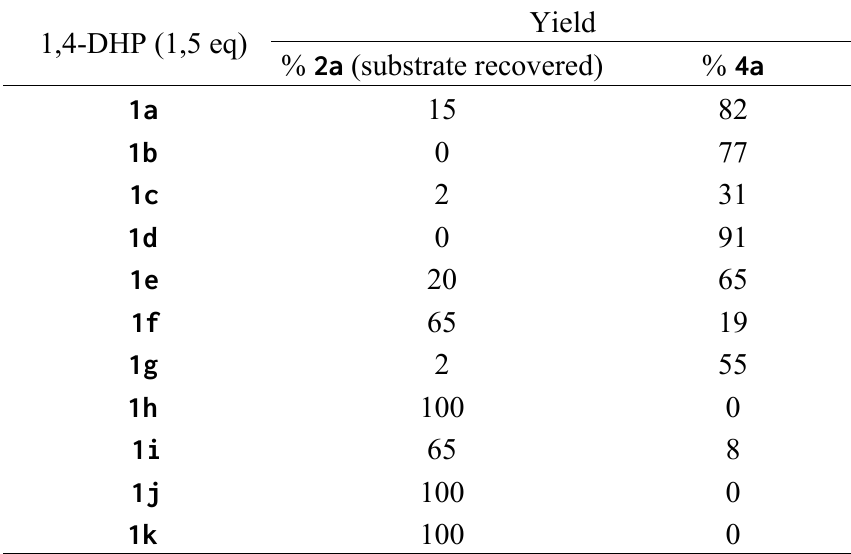
Table 2. Reduction of nitrostyrene by different